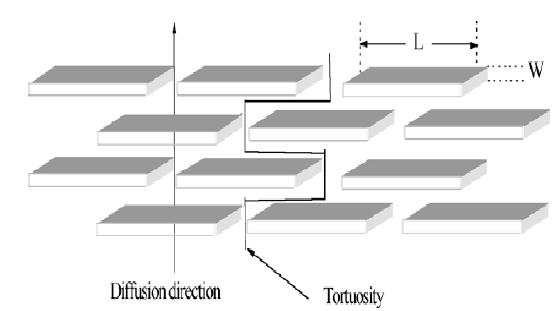
Fig . 2. Diffusion path through the nanocomposite [6].